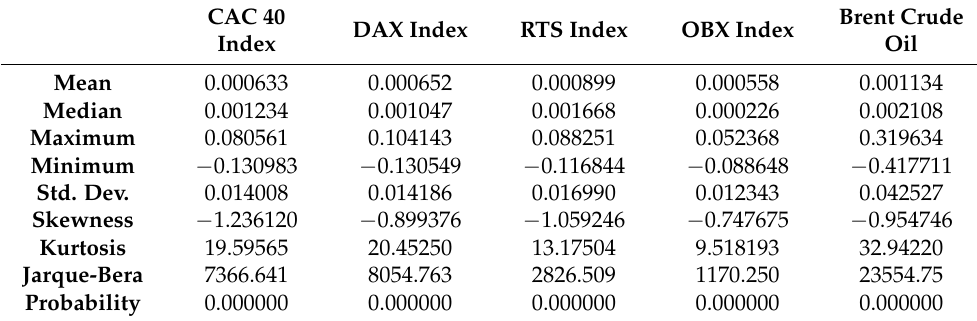
Table 1. Descriptive Statistics for Stock Indices and Crude Oil Returns (2019–2021).